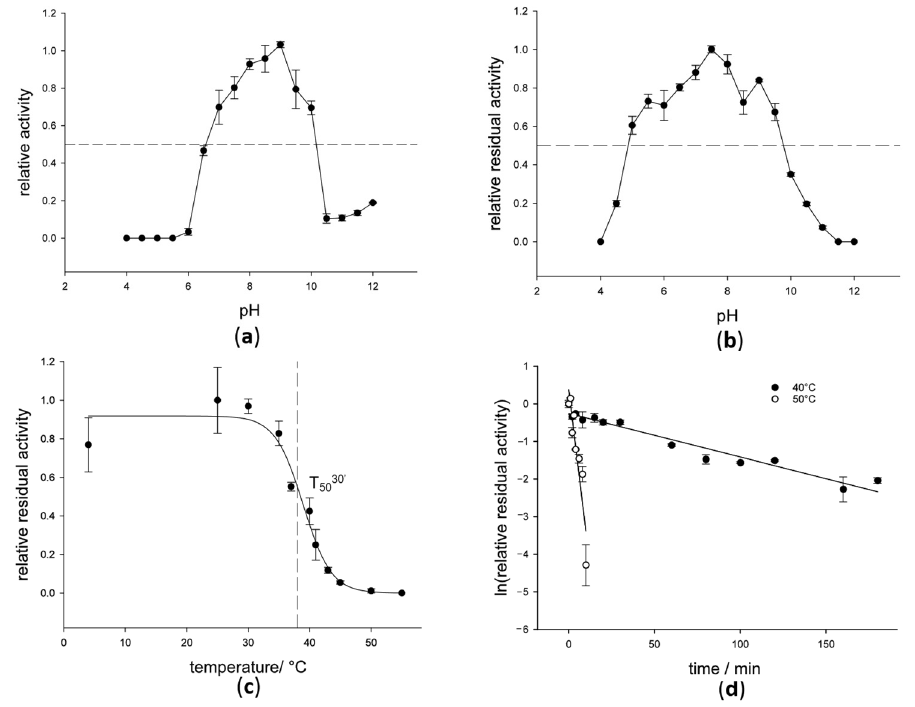
Figure 4. Enzyme stability explored with different approaches: ( a ) pH optimum profile for Sc POx at 30 °C. Areas in the plot that have more than 50% activity retained are indicated with a dashed horizontal line; ( b ) pH stability profile for Sc POx at 30 °C. Area in the plot that has more than 50% of activity retained is indicated with a dashed horizontal line; ( c ) T 5030’ profile for Sc POx in 50 mM potassium phosphate buffer, pH = 6.5 and ( d ) half-life times at 40 and 50 °C in 50 mM potassium phosphate buffer, pH = 6.5. Measurements were done in triplicates and the mean value ± standard deviations are shown.